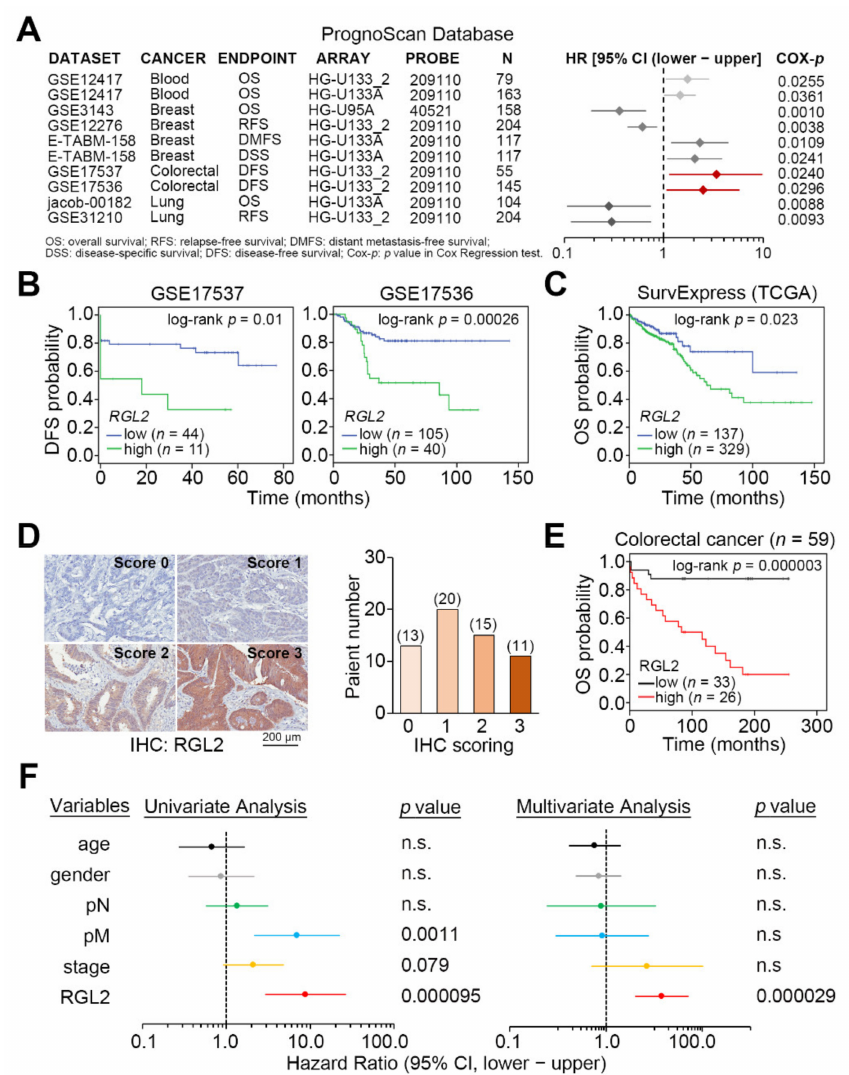
Figure 2. RGL2 upregulation refers to a poorer prognosis in colorectal cancer (CRC) patients. ( A ) For- est plot for the hazard ratio (HR) of RGL2 (high expression vs. low expression) in a meta-analysis using the PrognoScan database. Cox-p denotes the p value obtained from the Cox repression test. ( B , C ) Kaplan-Meier analyses for RGL2 transcript using disease-free survival (DFS) and overall sur- vival (OS) under a minimized p value against CRC cohorts from the GSE17537/GSE17536 datasets ( B ) and the TCGA database ( C ). ( D ) Representative immunohistochemistry (IHC) scoring for the protein intensity of RGL2 (left) and the patient number in each IHC score (right). ( E ) Kaplan-Meier analysis for the low (scores 0 and 1) and high (scores 2 and 3) protein levels of RGL2 determined by IHC experiment against the enrolled CRC patients in the commercial tissue microarray. ( F ) Cox regression test using univariate and multivariate models for RGL2 protein levels (high vs. low) under OS conditions against the enrolled CRC patients in the commercial tissue microarray. The ‘n.s.” denotes not